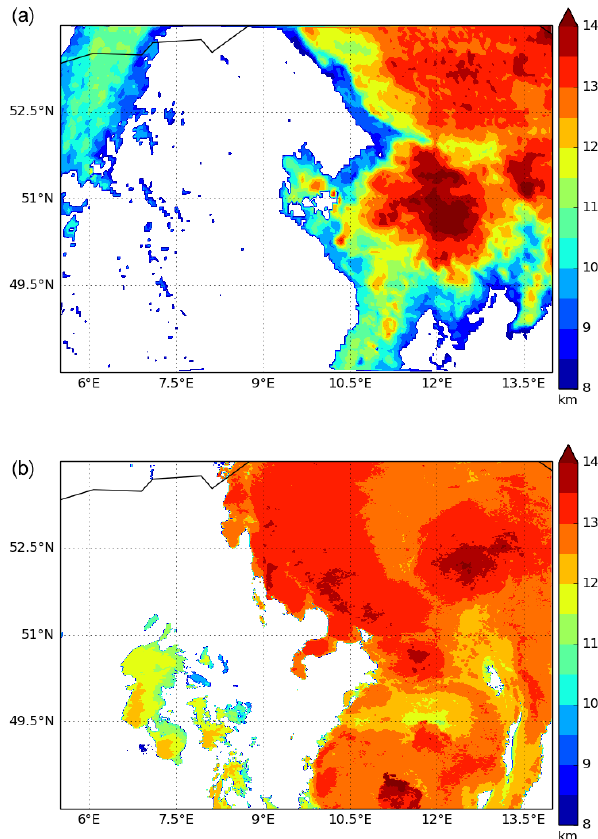
Figure A2. Observed (a) and simulated (b) horizontal distribution of CTHs of ice clouds at 22:00UTC for 4 July 2015 over Germany. CTHs below 8km are not